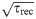
Theoretical analysis of resonance in phase change vs system dynamics.Subfigures A and C show, for M = 512, that the mathematically predicted resonance in the phase change observed in Fig 6A depends strongly on the longest time constant in the system, τrec and on the vesicle release probability, Pv. Subfigures B and D show, for M = 512, that the period of the resonance has an approximately linear relationship with τrec and Pv. Together, τrec and Pv determine the time course of depression, which determines phase.